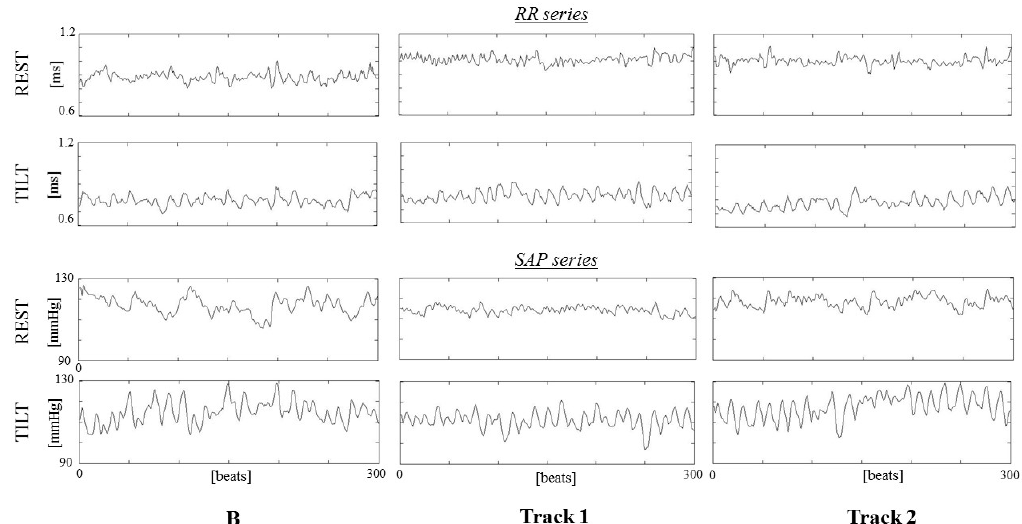
Figure 2. Example of RR ( upper panels ) and SAP ( lower panels ) series for each studied condition (B, baseline on the left, Track1 in the middle and Track2 on the right) during resting (REST, line 1 and 3 from the top) and tilting (TILT, line 2 and 4 from the top).